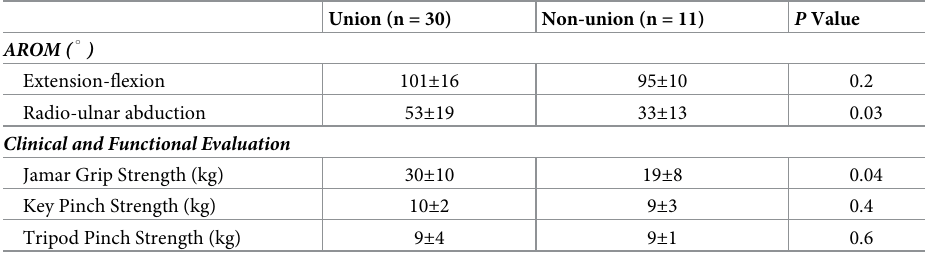
Table 4. Comparison of outcomes between patients who achieved union and those who did